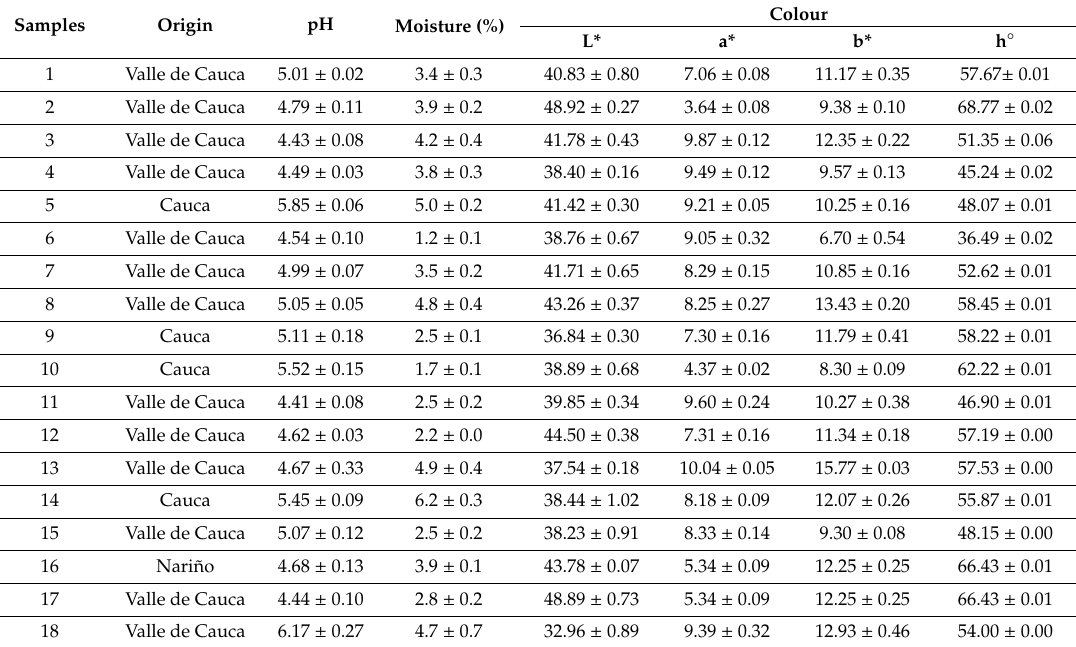
Table 2. Chemico-physical and colour parameters (L*, a*, b* and h ◦ ) for fermented and dried samples (T1). The data are expressed as mean ± standard